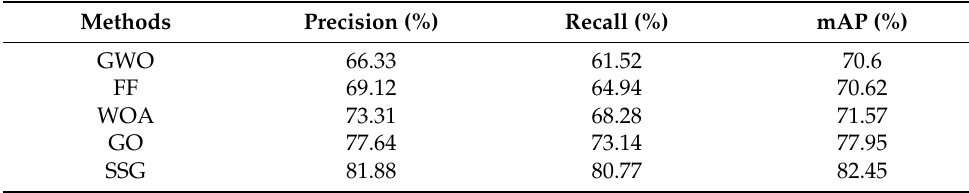
Table 2. Feature selection techniques performance on DOTA